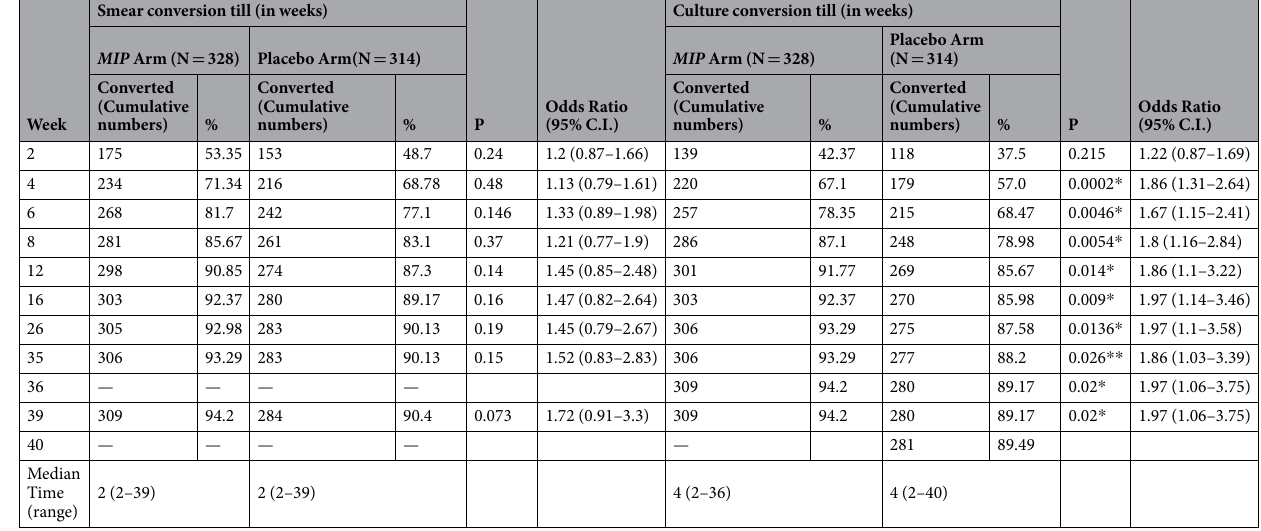
Table 2. Sputum-smear and culture conversion time in per protocol group i.e. patients who completed the